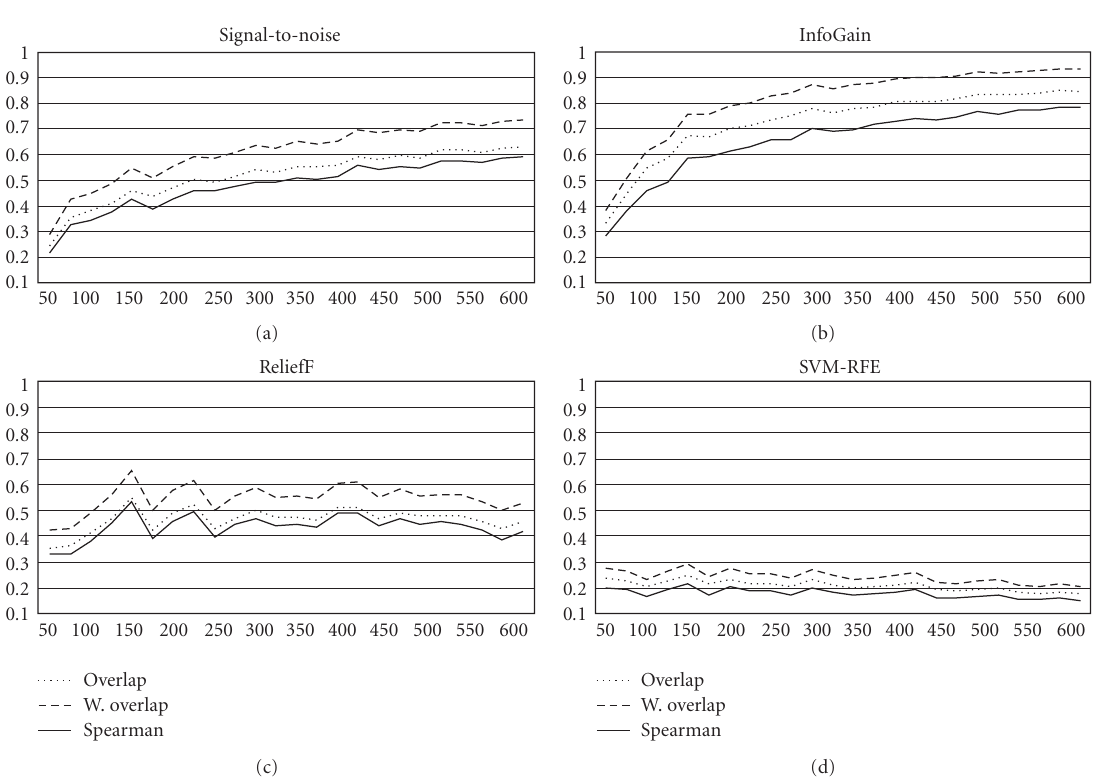
Figure 1: Relation between the number of samples and stability using resampling technique (breast versus colon cancer data set). genes would be needed to achieve an overlap of 50%